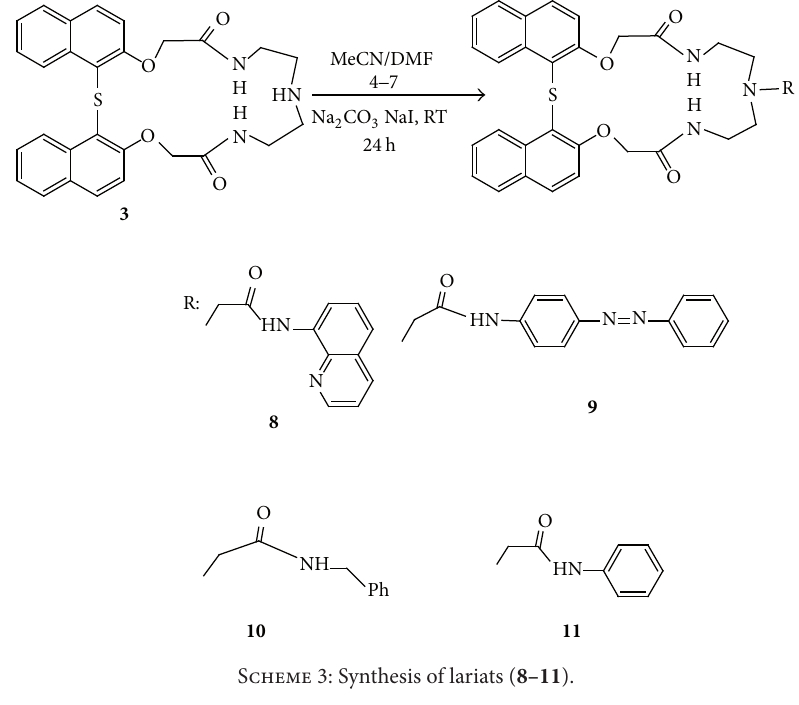
S 3: Synthesis of lariats ( 8–11 ).